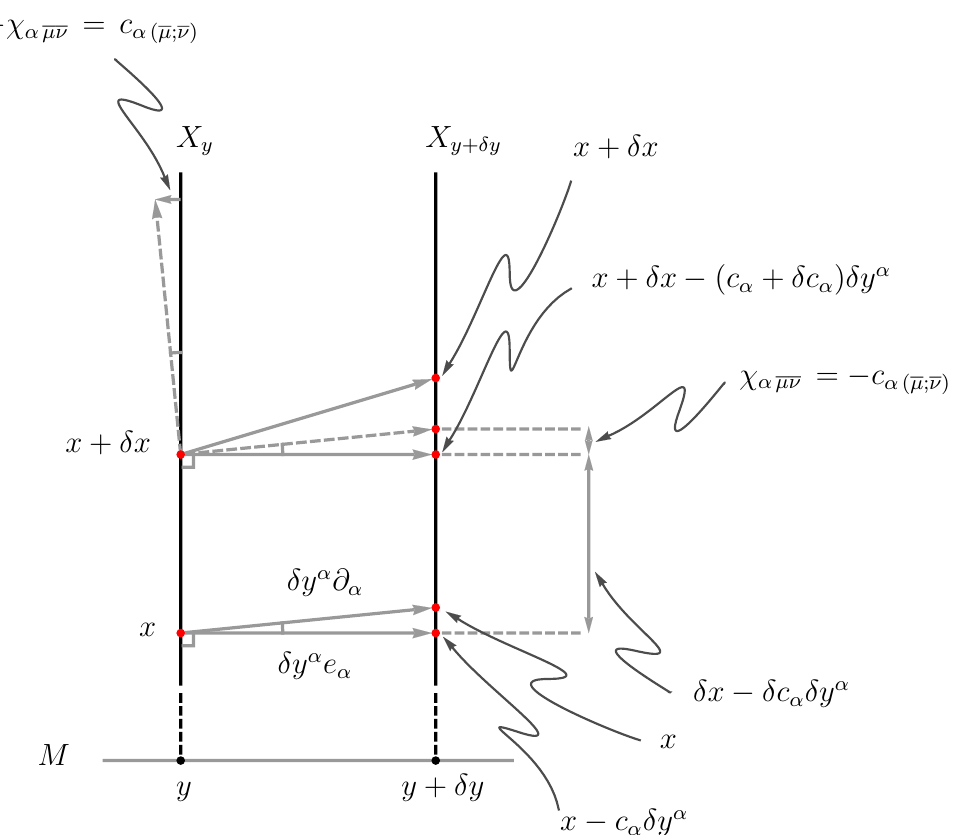
Figure 3 . The calculation of the extrinsic curvature for the fibres X y for the case of complex